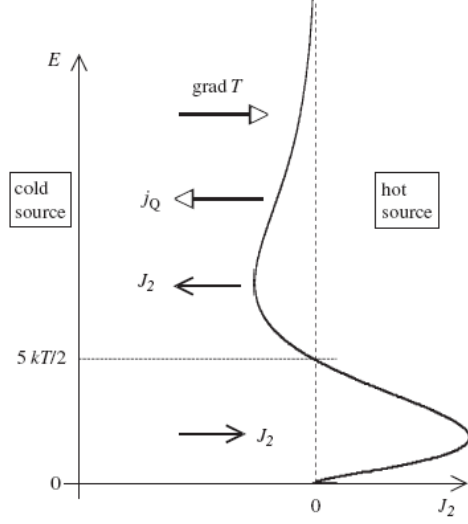
Figure 6. Particle and heat flows in a monoatomic gas subjected to a temperature gradient at steady state. The spectral particle-current density J